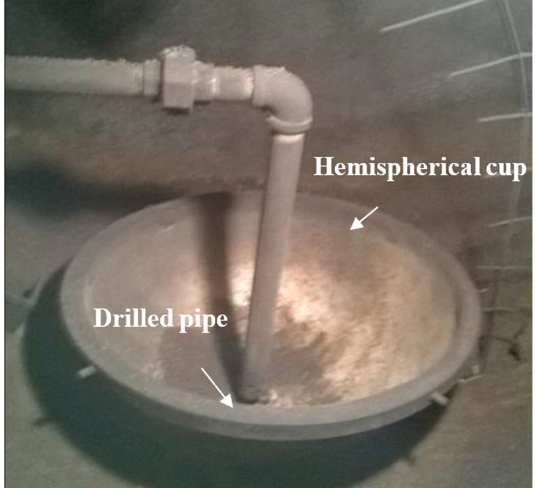
Figure 3. Drilled pipe hemispherical disperser.